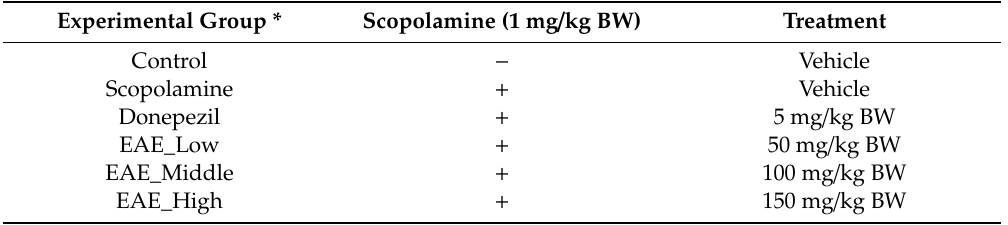
Table 1. Experimental groups for animal behavioral